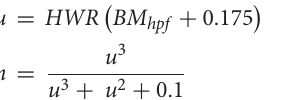
Frontiers in Neuroscience |